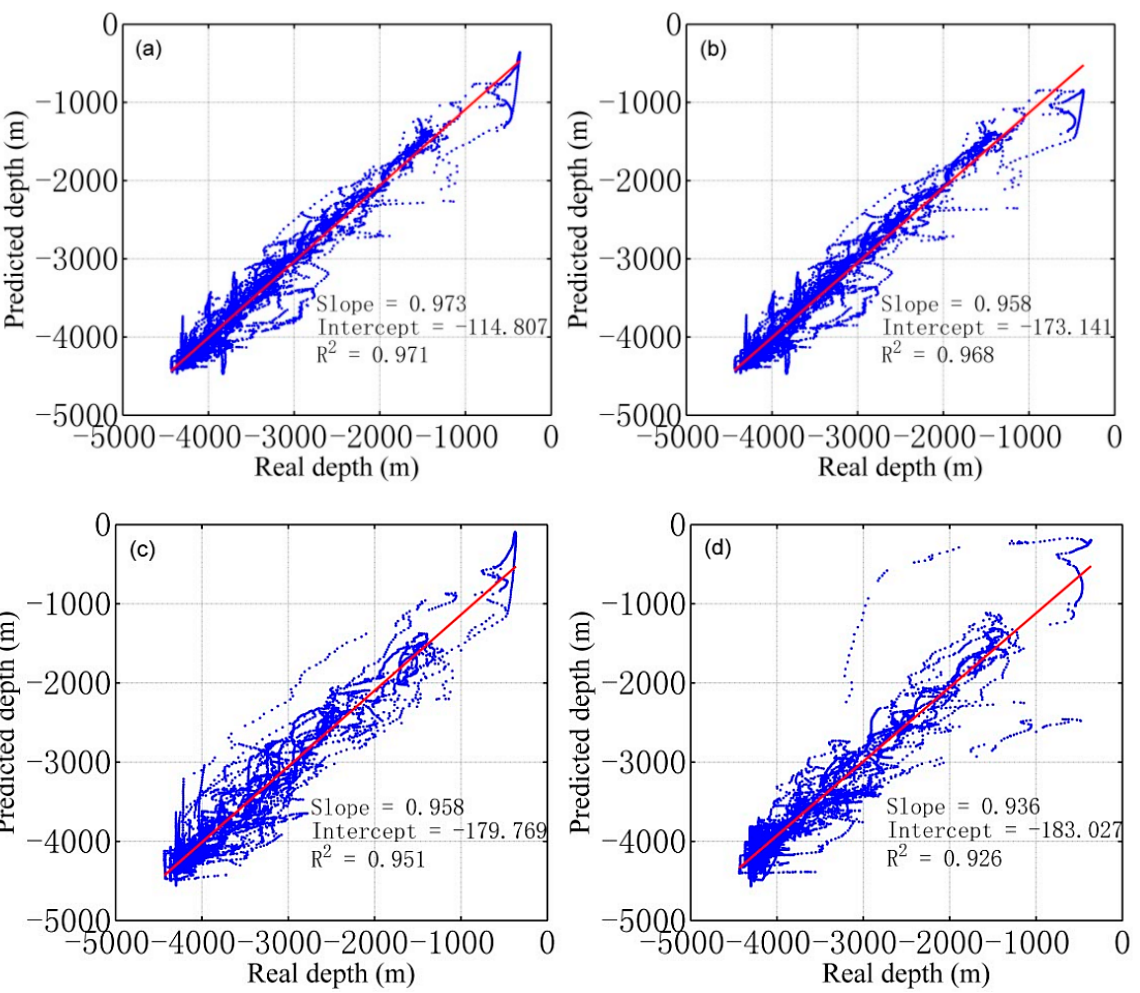
Figure 8. Regression fitting results of the predicted depth of four different models and the real depth of the SSD: ( a ) the result for ST1, ( b ) the result for ST2, ( c ) the result for ETOPO1, and ( d ) the result for DTU10. The red line indicates the fitted result. R 2 is the fitted correlation coefficient.